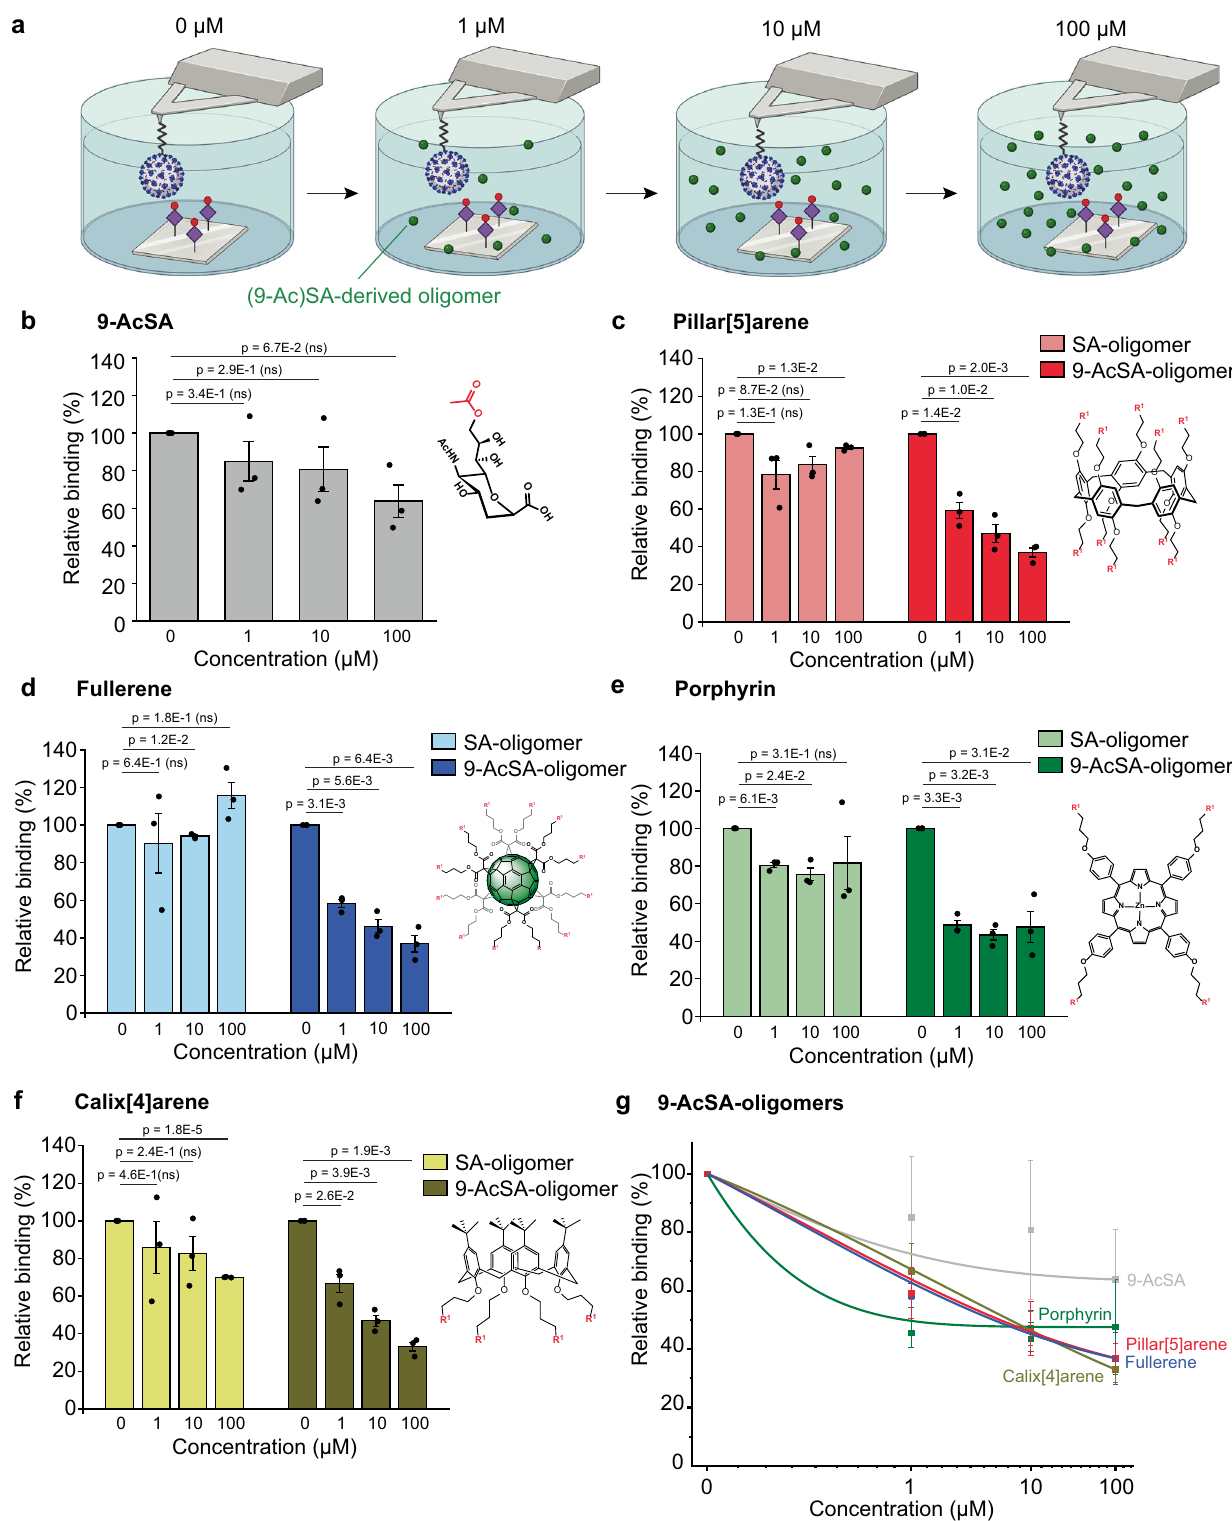
Fig. 5 Screening of the anti-binding properties of SA-derived glycoclusters. a The ef fi ciency of blocking glycoclusters is evaluated by measuring the BP of the interaction between 9-AcSA coated surfaces and SARS-CoV-2 before and after incubation with the oligomers at increasing concentration (1 – 100 µ M). b – f Normalized histograms showing the relative BP of the interaction between 9-AcSA and SARS-CoV-2 before and after incubation with 1, 10, or 100 µ M of free 9-AcSA ( b ), Pillar[5]arene ( c ), fullerene ( d ), porphyrin ( e ), or calix[4]arene. g Graph showing the reduction of the BP. Data are representative of at least N = 3 independent experiments (tips and sample) per SA dendrimer concentration. P -values were determined by two-sample t-test in Origin. The error bars indicate s.d. of the mean value. Panel a was created with BioRender.com. Source data are provided as a Source Data fi